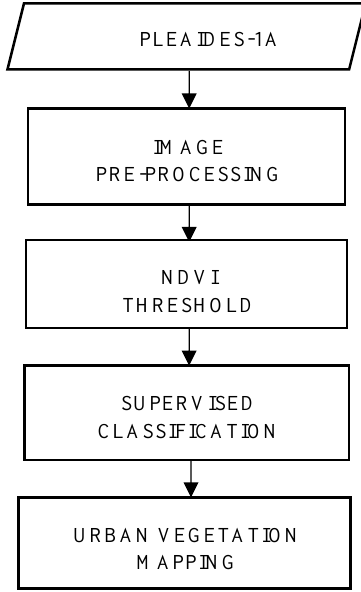
Figure 2: Research flow chart of urban vegetation